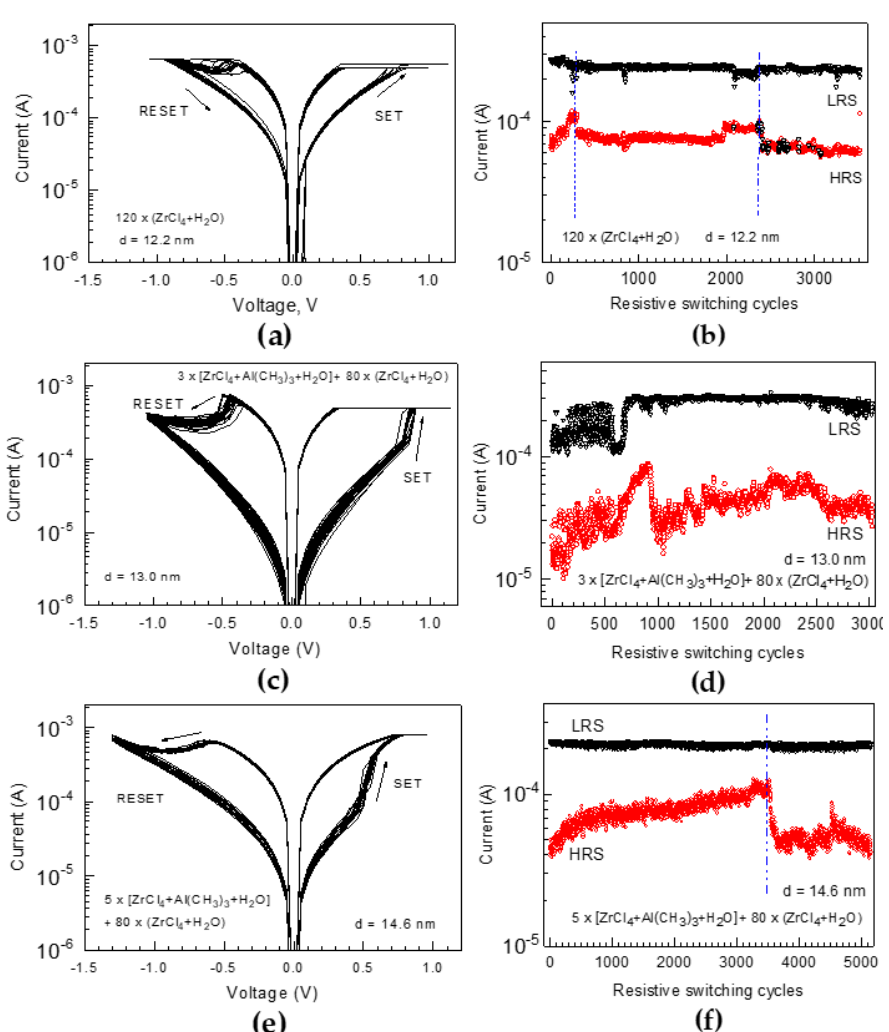
Figure 11. ( a ) Current–voltage switching and ( b ) endurance characteristics of a ZrO 2 reference film, compared to ( c ) current–voltage and ( d ) endurance behavior of a Zr x Al y O z -ZrO 2 stack deposited using 3 Zr x Al y O z and 80 ZrO 2 ALD cycles, and ( e ) current–voltage and ( f ) endurance test results for a Zr x Al y O z -ZrO 2 stack deposited using 3 Zr x Al y O z and 80 ZrO 2 ALD cycles. The deposition cycle sequences are indicated by labels.